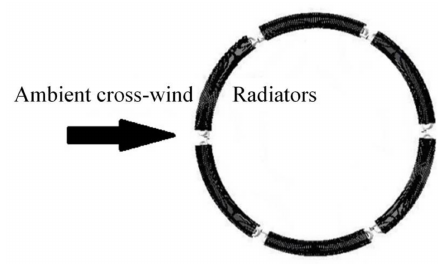
Figure 6. Radiator installation configuration of the experimental